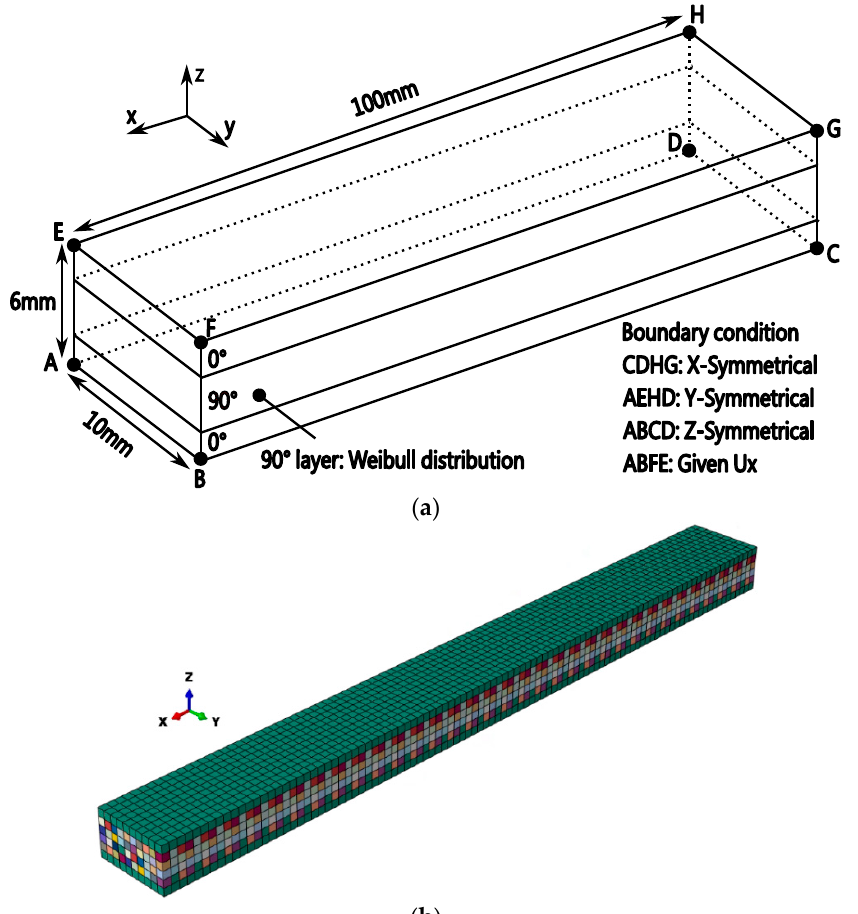
Figure 10. Cross-ply CFRP structures subjected to cyclic loading. ( a ) Geometric model under cyclic loading: symmetric boundary conditions are applied on face ABCD, CDHG and AEHD, respectively; ( b ) Finite element model (color denotes the material property).